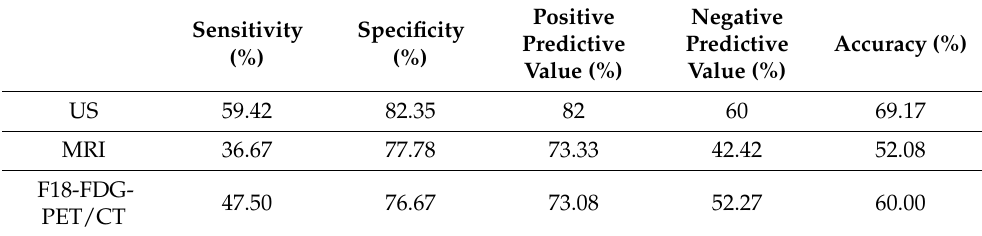
Table 3. Specificity, sensitivity, and negative and positive predictive values of imaging techniques for evaluating complete axillary response after neoadjuvant chemotherapy.